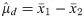
JZS Bayes Factor vs. pCET.Based partially on Fig 5 from Rouder et al. (2009) [93]. Left (middle; right) panel shows how the JZS Bayes Factor (the posterior probability of H0; pCET) changes with sample size for four different observed mean differences, μ^d=x¯1-x¯2. The observed variance is constant, sp2=1.